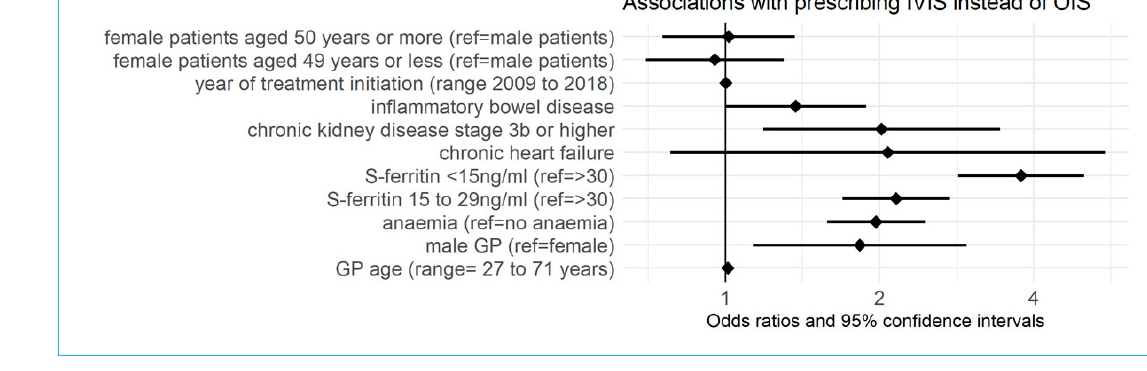
Figure 2: Odds ratios and 95% confidence intervals of variables’ associations with prescribing IVIS instead of OIS, n = 3484. OIS = oral iron supplementation; IVIS = intravenous iron supplementation; S-ferritin = serum ferritin; GP = general